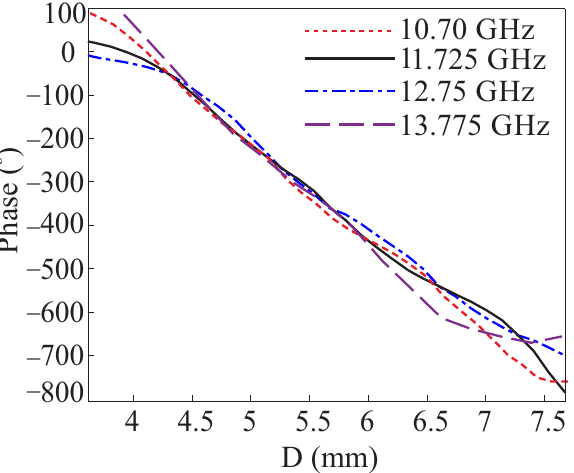
Figure 4. Normalized reflection phase curves at different frequencies over the